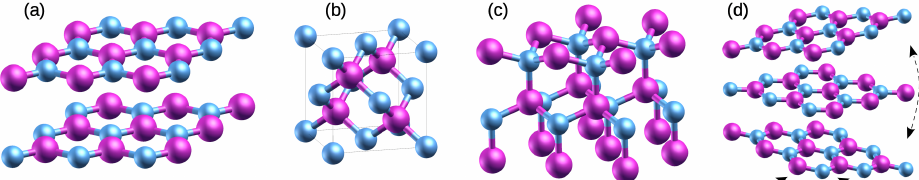
Figure 1. BN polymorphs. The stacking of boron (magenta spheres) and nitrogen (blue spheres) atoms for ( a ) the sp 2 bonded hBN, and sp 3 bonded ( b ) zinc blend, and ( c ) wurtzite polymorphs and ( d ) the turbostratic disordered stacking. The vertical axis is the (cid:104) 001 (cid:105) crystallographic direction for all the